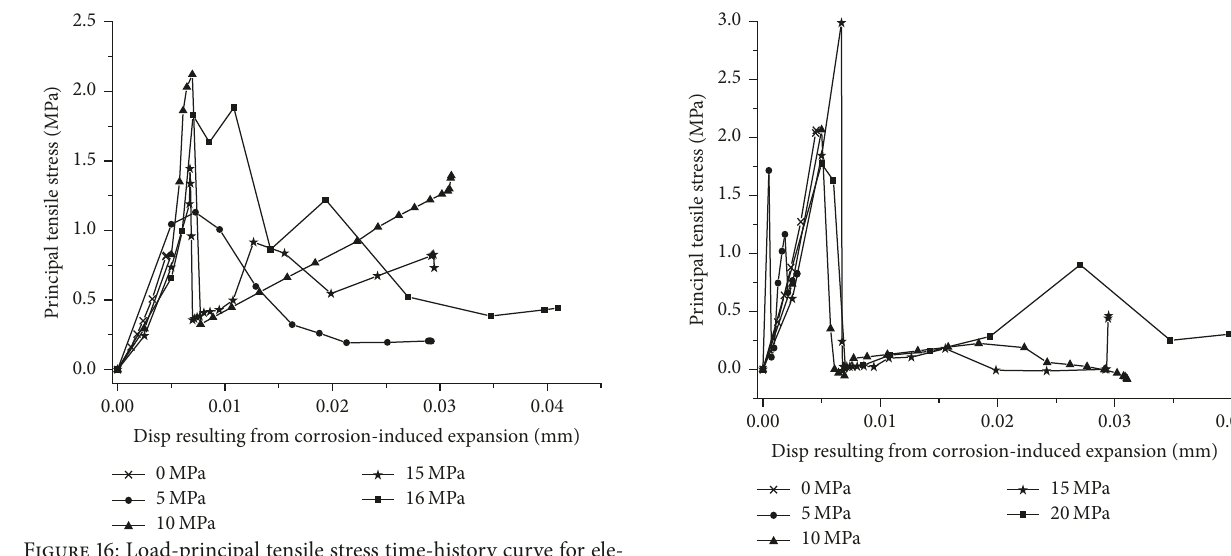
Figure 18: Load-principal tensile stress time-history curve for ele- ment